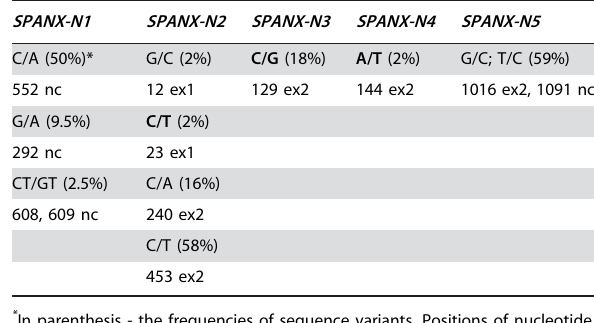
Table 1. Nucleotide variations in the human SPANX-N1 -, - N2 ,